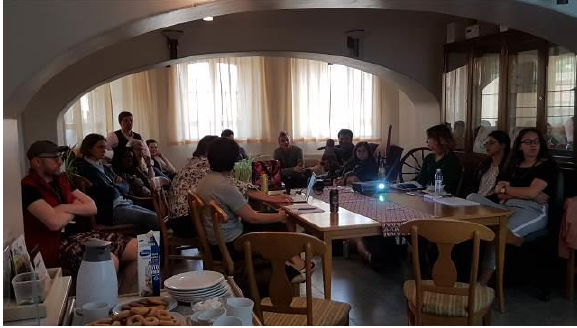
Figure 14. Open Roundtable session with community members, at the officer club